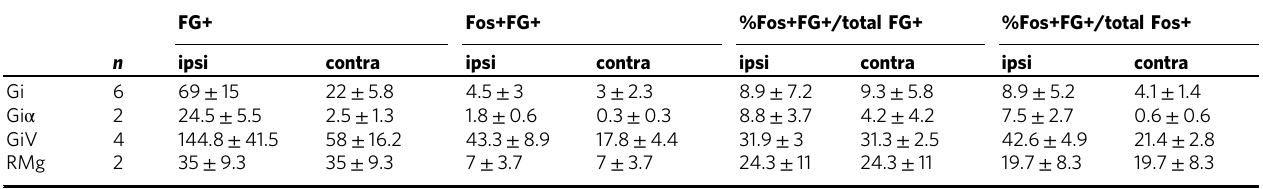
Table 2 Numbers of vmM neurons retrogradely labeled from lumbar cord expressing c-Fos during PS recovery